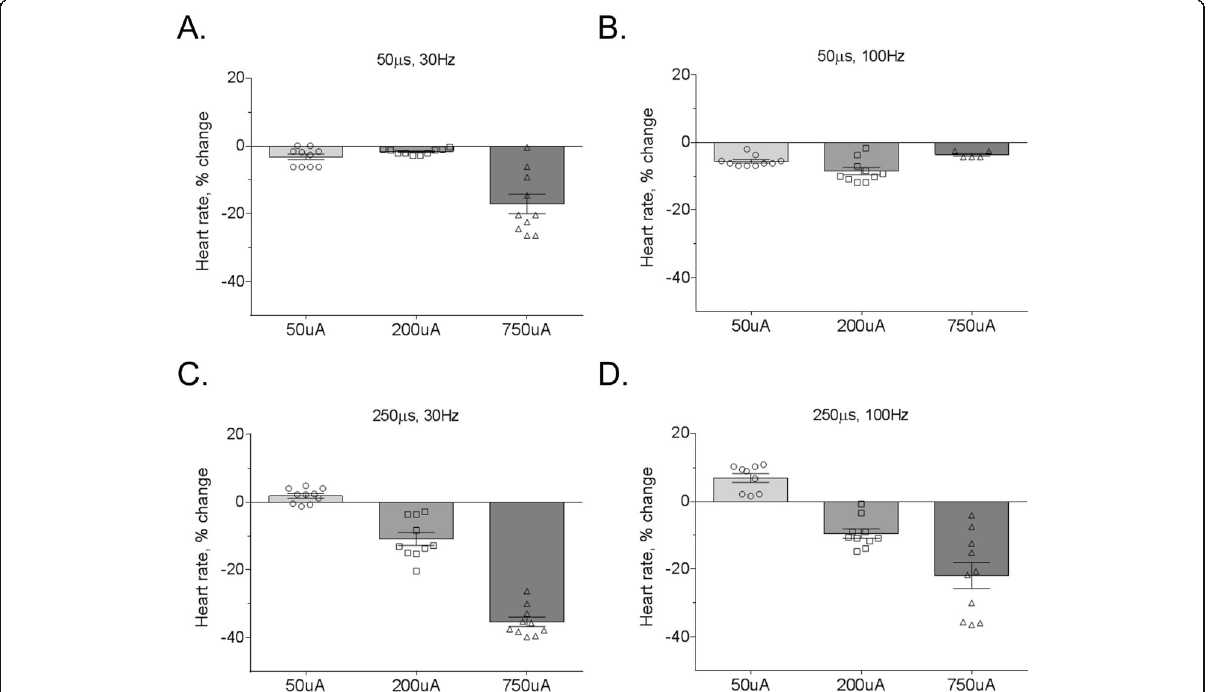
Fig. 6 The effect of different vagus nerve stimulation parameters on heart rate. a Stimulation at 30 Hz with 50 μ s pulse width resulted in bradycardia ( ≥ 10% reduction in heart rate) at only the 750 μ A pulse amplitude. b At 100 Hz, bradycardia was not observed with the 50 μ s pulse width. c Stimulation with the longer 250 μ s pulse width resulted in bradycardia at 200 and 750 μ A pulse amplitudes. d The largest decrease in heart rate was observed with the 250 μ s pulse width at 100 Hz and 750 μ A amplitude. Data is represented as individual mouse data points with mean ± SEM. n = 5 – 10 per